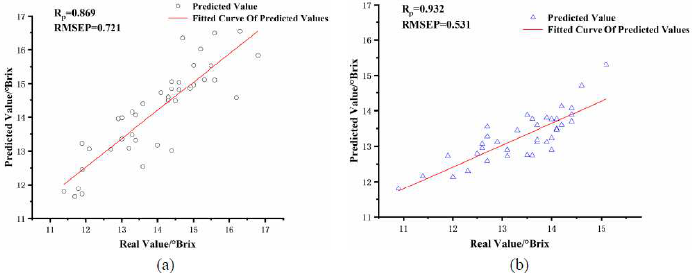
Table 5. PLSR results were established after the spectra